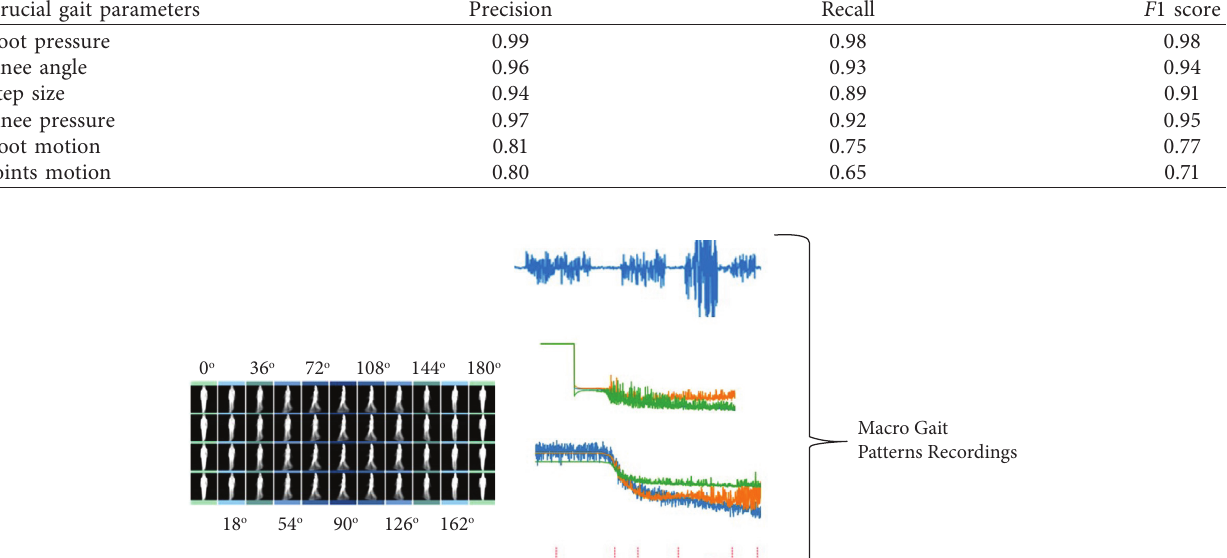
Figure 6: Extraction of macro-gait patterns, such as foot pressure, knee motion, knee angle, and step size, from CASIA-B dataset.